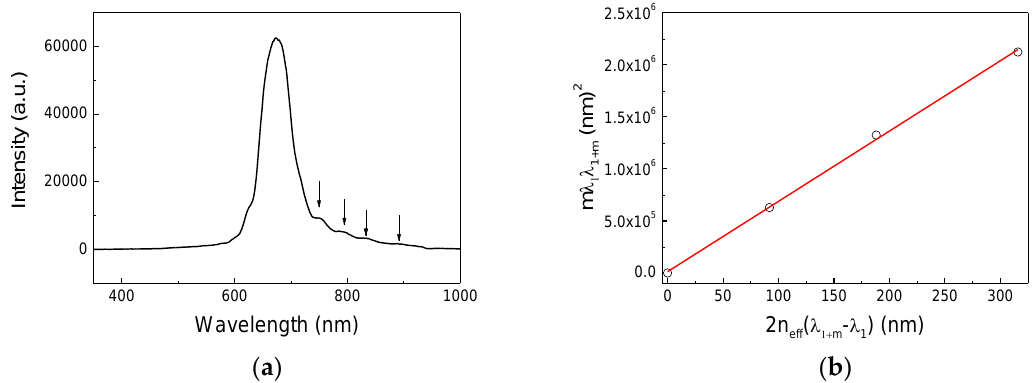
Figure 4. ( a ) Reflectance spectrum acquired at normal incidence on the inverse silica opal, the arrows correspond to the position of the Fabry-Perot fringes considered for the estimation of the thickness. ( b ) Experimental values of m λ 1 λ 1+ m plotted as a function of 2 n eff ( λ 1+ m − λ 1 ) and the corresponding linear fit.